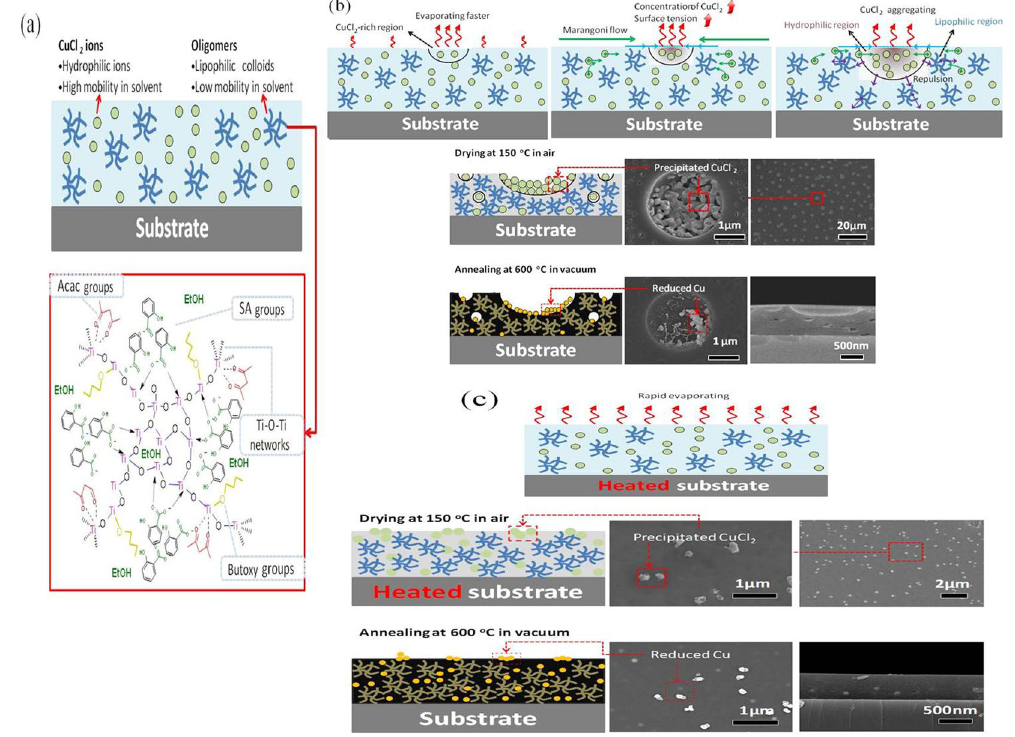
Figure 8. Illustration diagrams of the preparation mechanism. ( a ) Gel film on the substrate ( b ) normal solvent evaporation causing Marangoni flow results porous morphology ( c ) rapid evaporation suppressing Marangoni flow results nearly smooth